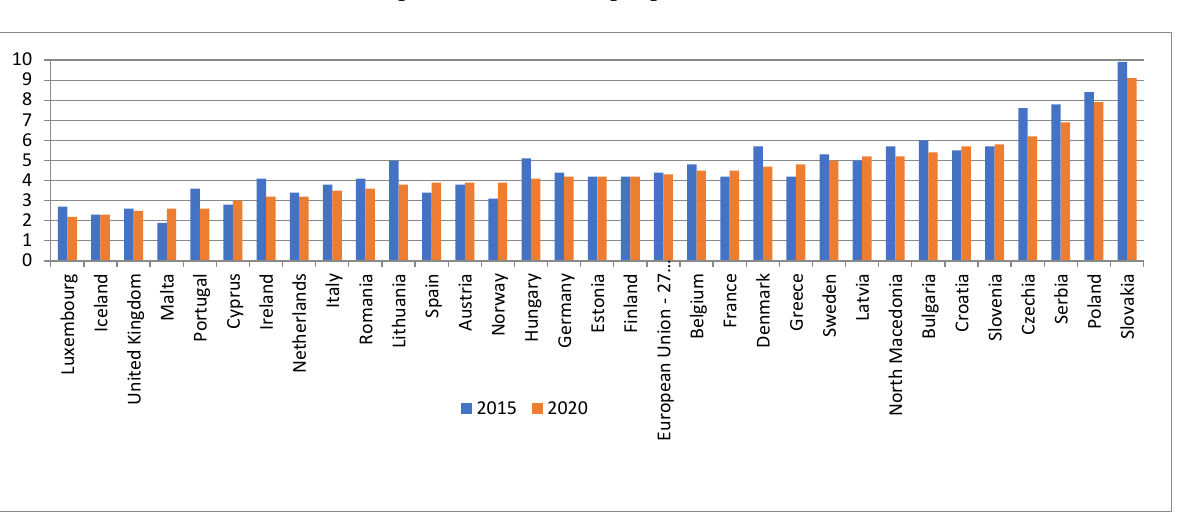
Figure 8. Electricity, gas. and other fuel expenditure for households in 2015 and 2020 in European countries (in%). Source: own preparation based on Eurostat database [47].